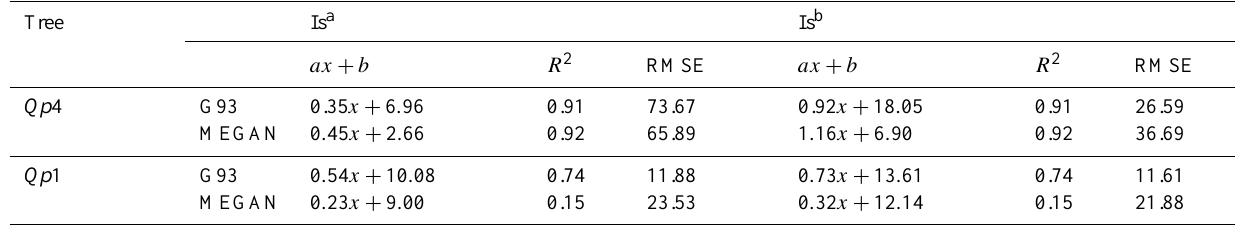
Table 3. Results of the comparison between calculated vs. measured Q. pubescens isoprene emission rates using both the G93 and MEGAN algorithm. The ax + b best fit equations are given, together with the determination coefficient ( R 2 ) and the root mean square error (RMSE). Tree Is a Is b ax + b R 2 RMSE ax + b RMSE Qp 4 G93 0.35 x + 6 . 96 0.91 73.67 MEGAN 0 . 45 x + 2 . 66 MEGAN 0 . 23 x + 9 .